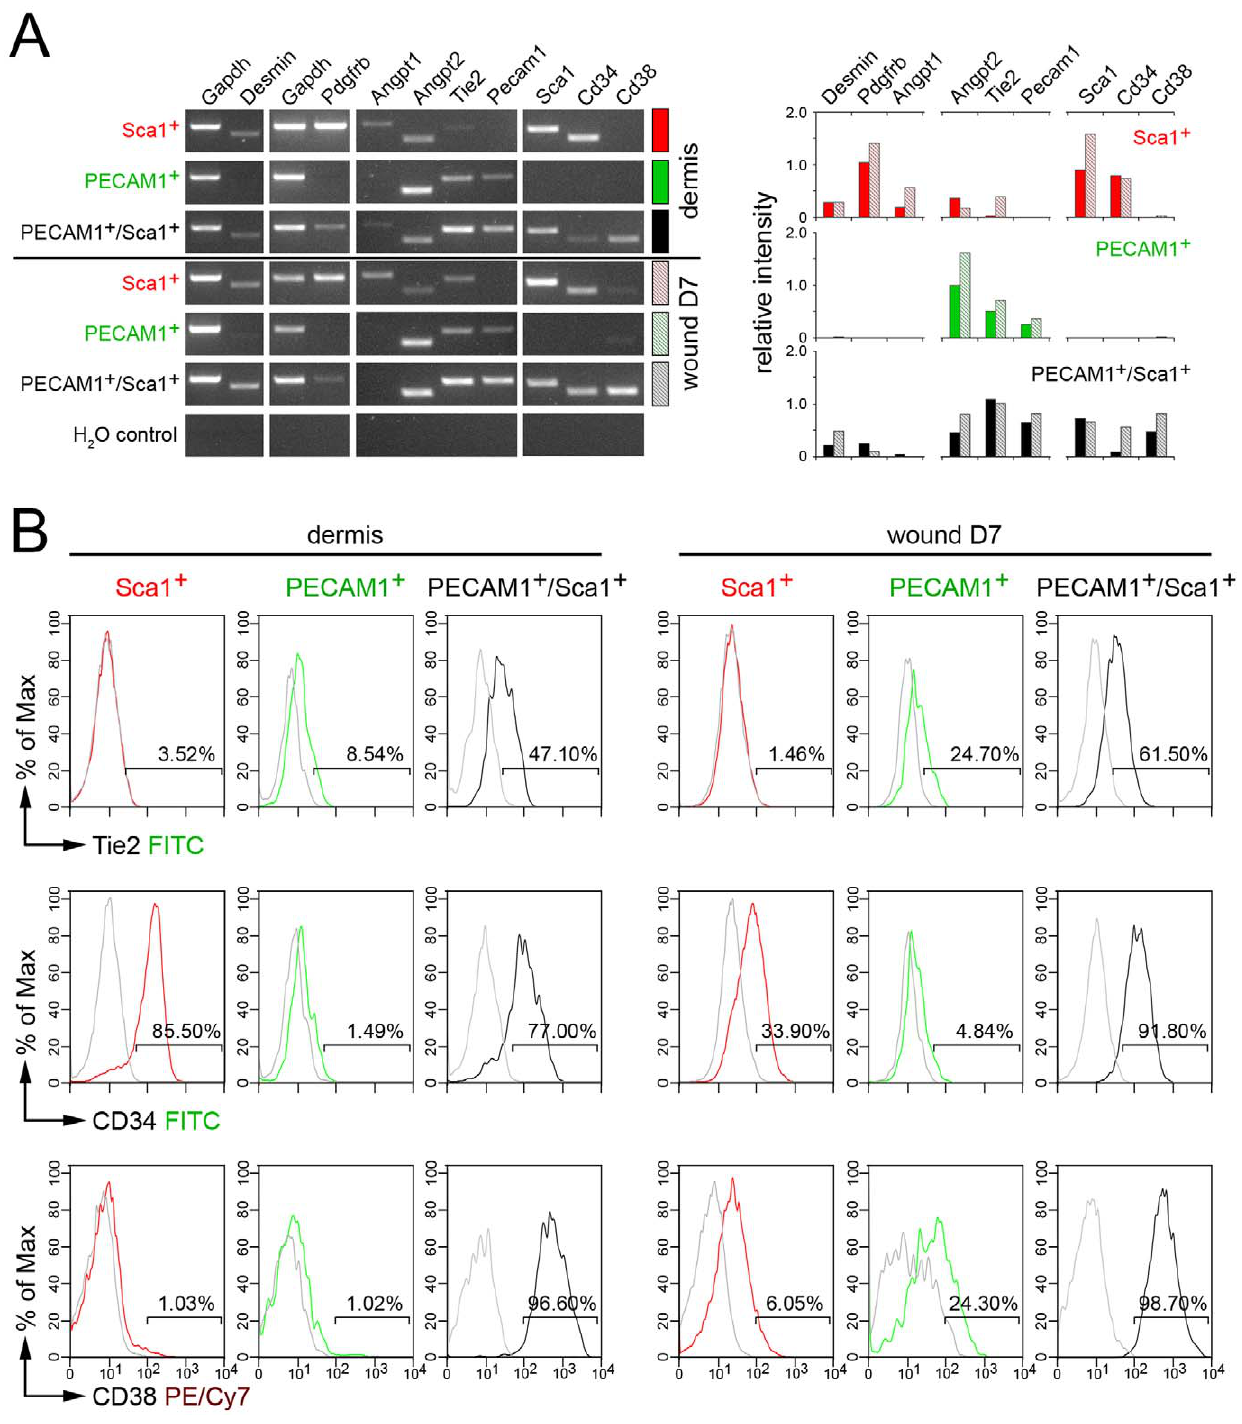
Figure 3. Expression profile of isolated Sca1 + , PECAM1 + and PECAM1 + /Sca1 + cells. Marker expression in the sorted cell populations isolated from dermis or wounds seven days post injury. (A) Relative mRNA expression levels of perivascular ( Desmin , Pdgfrb , Angpt1 ), endothelial ( Angpt2 , Tie2 , Pecam1 ), progenitor cell-specific markers ( Sca1 , Cd34 ) and of the CD38 receptor ( Cd38 ) were determined by semiquantitative RT-PCR in non-hematopoietic Sca1 + , PECAM1 + and PECAM1 + /Sca1 + cell populations. The band intensities of the electrophoretic gels were processed and quantified using Image J software. The relative expression intensity of the individual genes compared to Gapdh is given. The lack of Sca1 or Pecam1 expression in sorted PECAM1 + or Sca1 + cells demonstrated the purity of the cell fractions. (B) Flow cytometric detection of TIE2, CD34, CD38 expression at the cell surface of Sca1 + (red), PECAM1 + (green) and PECAM1 + /Sca1 + (black) cells isolated from dermis or full thickness wounds seven days post injury.